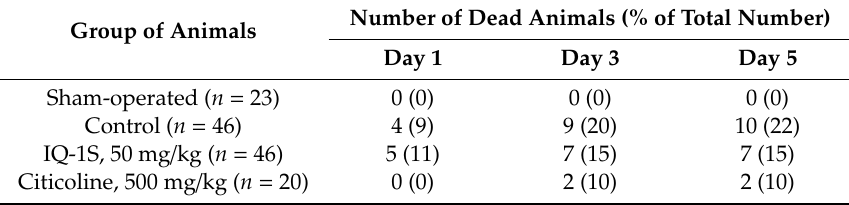
Table 1. The e ff ects of IQ-1S and citicoline on mortality of animals after global cerebral ischemia (GCI). Number of Dead Animals (% of Total Group of Animals